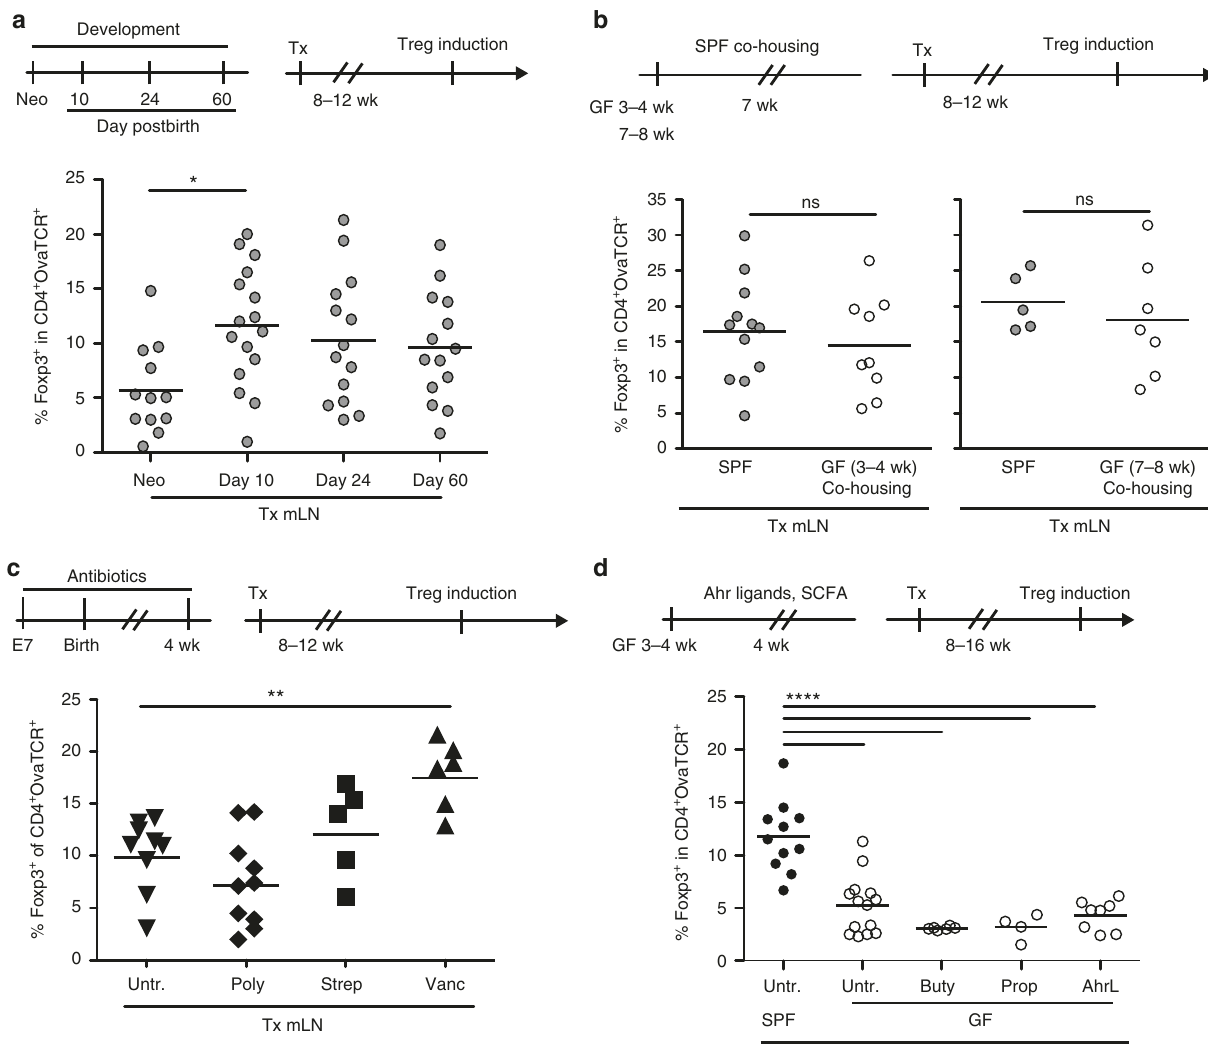
Fig. 2 Microbiota trigger imprinting of tolerogenic properties into mLN SCs early after birth. Indicated LNs were transplanted into the popliteal fossa of SPF- housed recipient mice. Eight to sixteen weeks later, transplanted mice received CPDviolet-labeled cells isolated from Foxp3 hCD2 xRag2 − / − xDO11.10 mice. On two consecutive days, recipients were immunized via repetitive i.v. injection of Ova 323-339 peptide and analyzed on day 3 after the fi rst immunization. a mLNs of neonatal, 10, 24, and 60 days old SPF-housed mice were transplanted. Scatterplot summarizes frequencies of de novo induced Foxp3 +